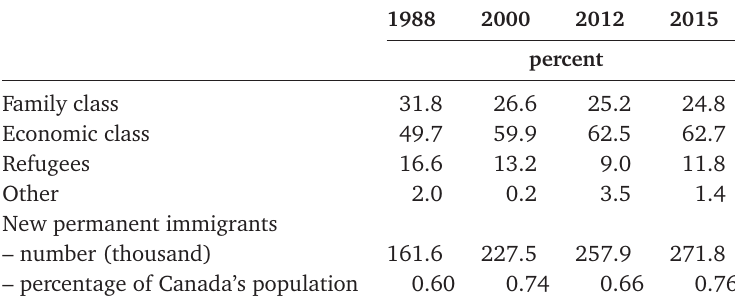
Table 8. Distribution of Permanent Immigrants by Category,